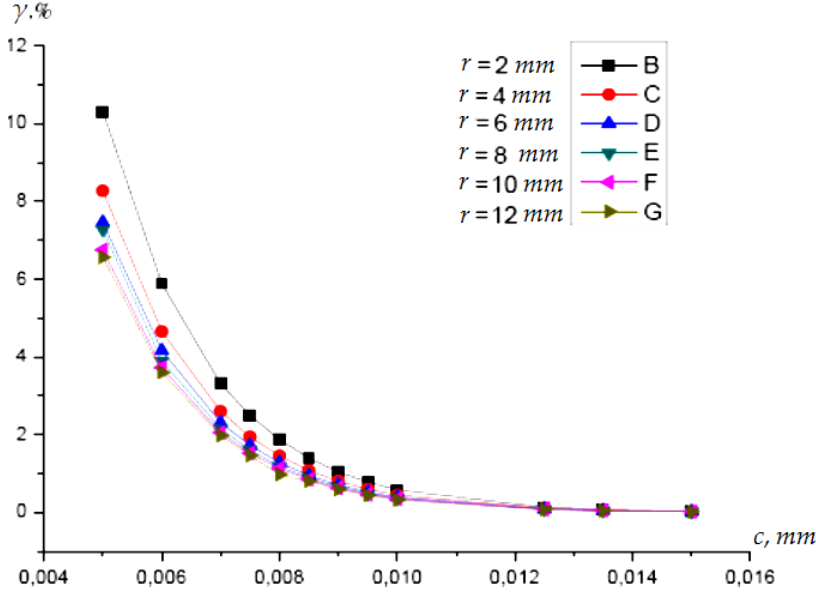
Figure 10. Dependence of the error γ = f ( c ) from the width of the guard electrode ( d = 5 mm). Using Formula (11) and the dependences shown in Figure 9 allows the width c of the security electrode to be determined at a given error value γ .